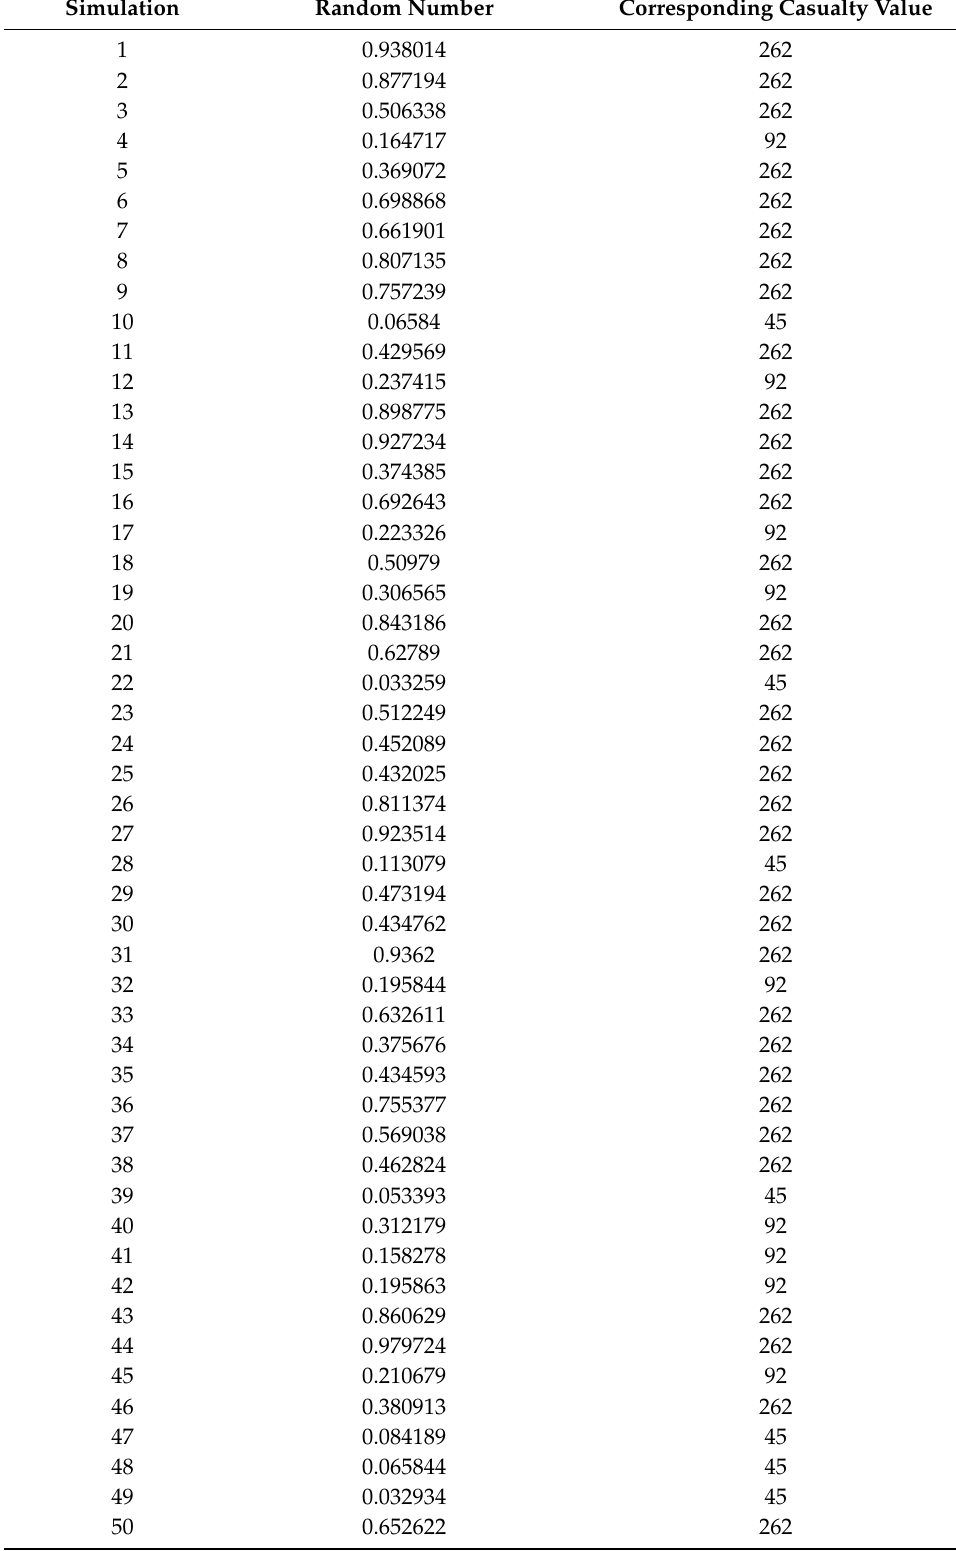
Table 4. Monte Carlo simulations with Boeing 737-Max excluded